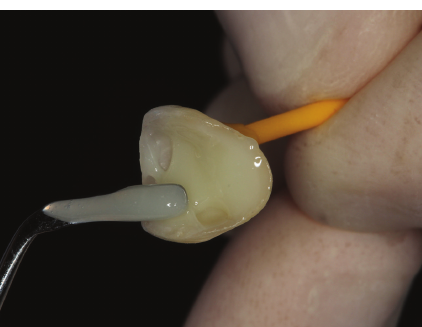
Figure 15: Lifelike esthetic result. Note the light transmission on restorations surface.